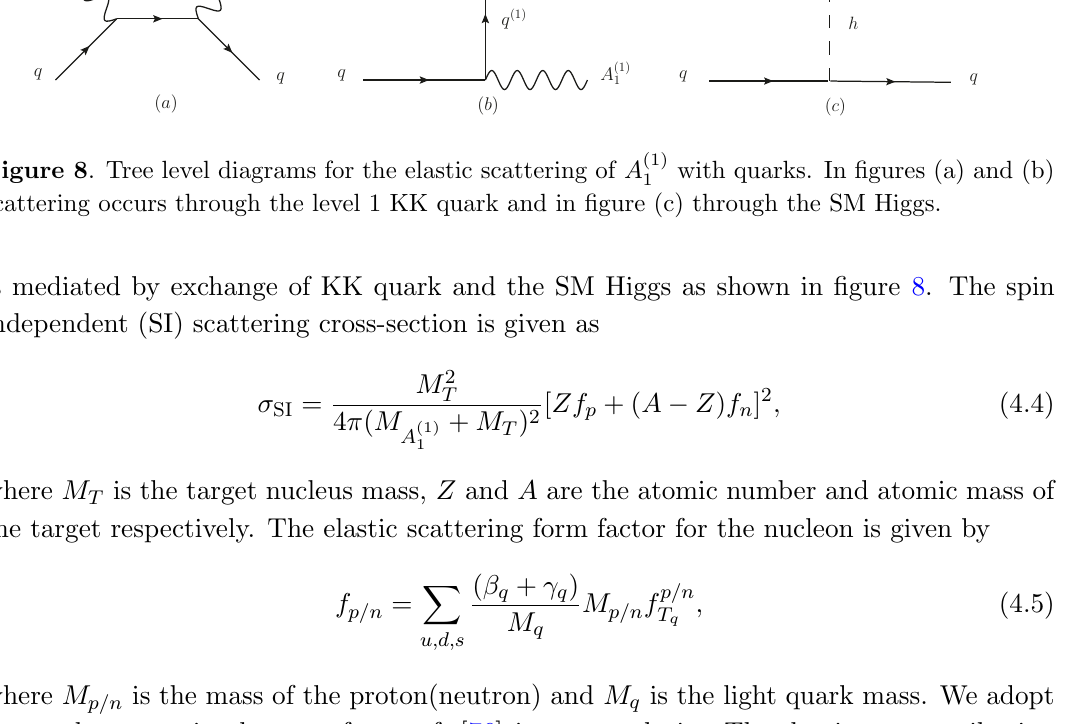
is mediated by exchange of KK quark and the SM Higgs as shown in (cid:12)gure 8. The